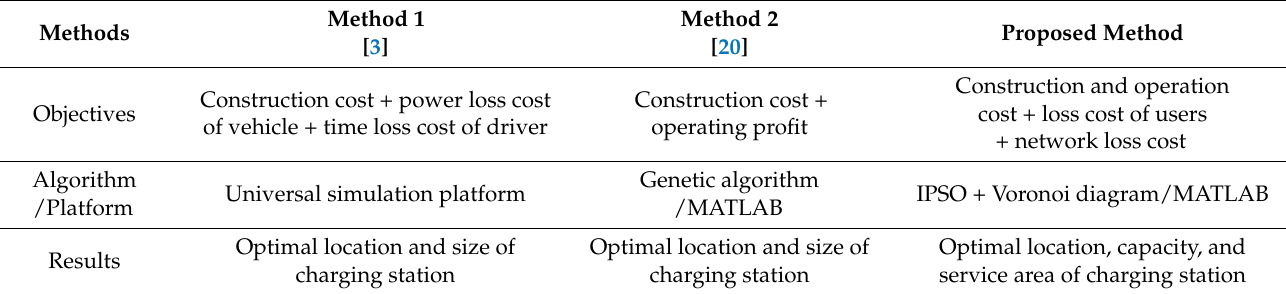
Table 3. Comparison of different